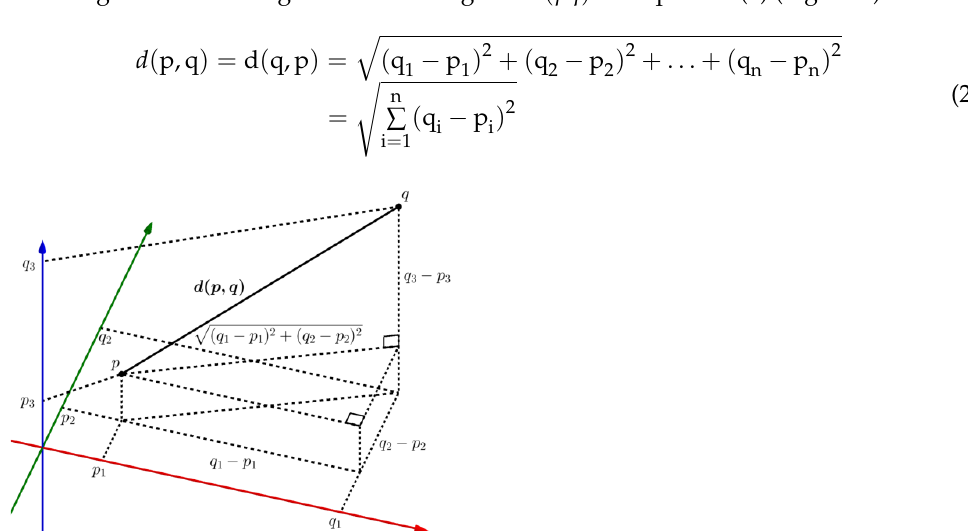
(3) Figure 4. Difference between Manhattan and Euclidean distances in measuring the distance be- tween points x and y . The k-nearest neighbor algorithm is one of the most popular classifiers used in food products sorting problems. It assigns an object to a category that is the most representative among the k-nearest samples of that object. Nearest samples are found by metric distance measure using the distance information of the nearest samples. Performance of k-NN highly depends on the k parameter and size of training set. Both of which should be large enough for optimal performance and small enough to avoid computational overload [34]. 2.4. Feature Extraction Feature extraction computes the feature vectors in the feature space from the input image. Necessary or appropriate properties features are extracted from the input image to distinguish images of different classes and, thus, prevent feeding of unnecessary infor- mation into the machine learning. The goal of classification is the definition of which